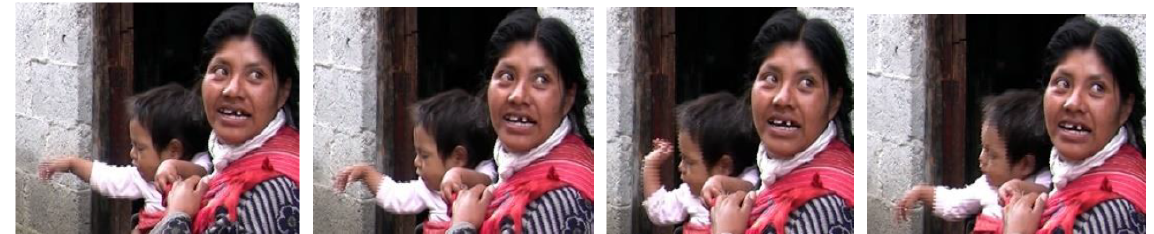
Figure 11. Vic appears to point and then make an extended wave.